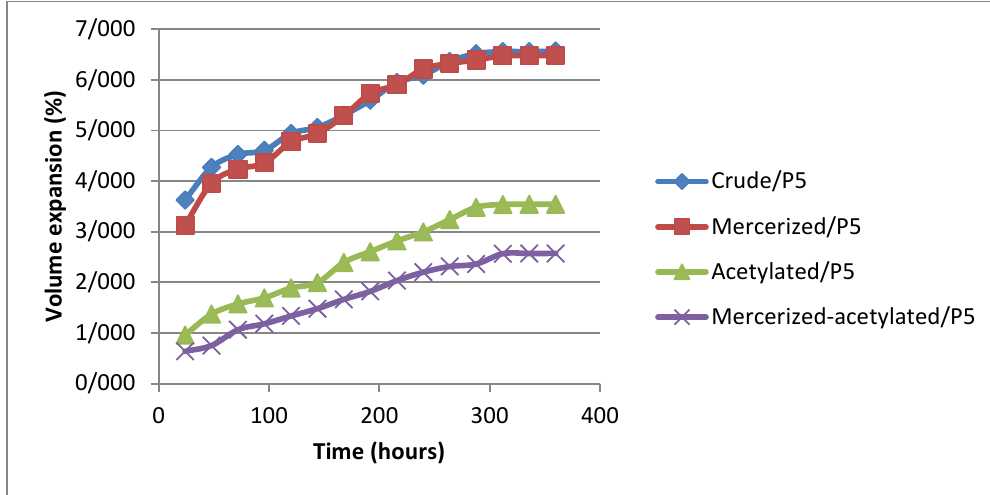
235 Fig. 21. Volume expansion due to moisture absorption at P4 fibre content.